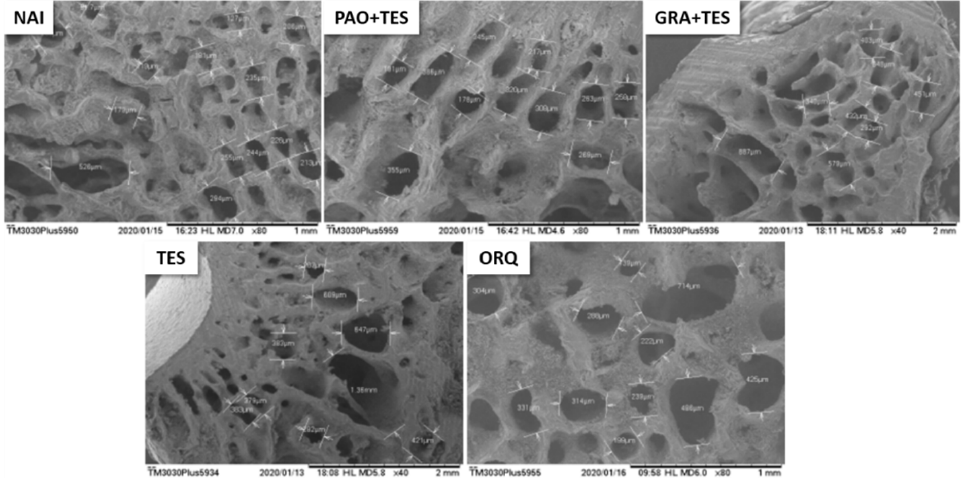
Figure 4. Representative scanning electron microscopy (SEM) pictures from transversal sections of the femur metaphysis with the trabeculae after 45 days of treatment. All the pictures were taken from the same area (in scaled from 1 mm to 2 mm) across the groups to ensure uniformity of the results. Note the more prominent trabeculae in the ORQ group. NAI: control naïve group; PAO + TES: orchiectomized group treated with purified annatto oil (200 mg/kg, p.o.) + testosterone (7 mg/kg, IM); GRA + TES: orchiectomized group treated with PAO granules (200 mg/kg, p.o., Chronic ® ) + testosterone (7 mg/kg, IM); TES: orchiectomized group treated only with testosterone (7 mg/kg, IM); ORQ: orchiectomized group treated only with water.